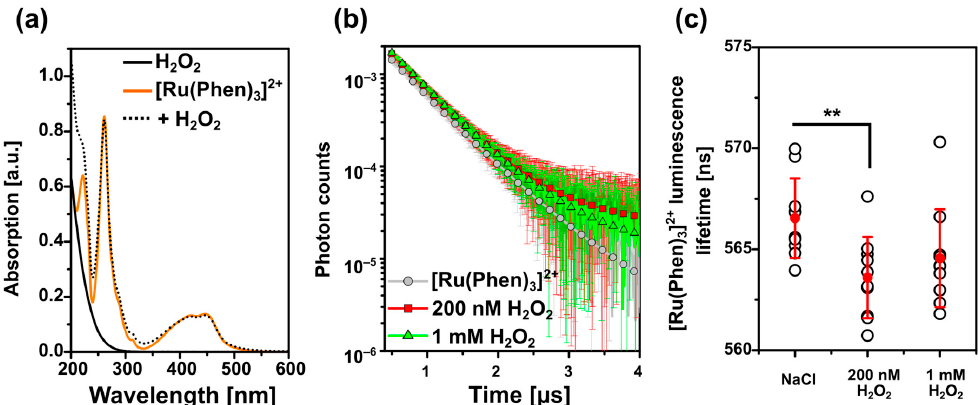
2+ (orange), and [Ru(Phen) 2+ with 1 mM H Figure 13: Figure 7. ( a ) Absorption spectra of 1 mM H µ M [Ru(Phen) 2 O 2 (black), 10 3 ] 3 ] 2 O 2 (dotted black) 0.9% NaCl solutions. ( b ) 10 µ M [Ru(Phen) 3 ] 2+ luminescence lifetime decays in 0.9% NaCl physiological solution (grey circles) and the presence of 200 nM (red squares) and 1 mM H 2 O 2 (green triangles). ( c ) [Ru(Phen) 3 ] 2+ luminescence lifetime values detected at the conditions mentioned in ( b ). The mean values of the decays and the lifetimes are the averages of ten measurements with the appropriated standard deviations as the error bars. The level of significance was assessed with the Student t -test: ** p <